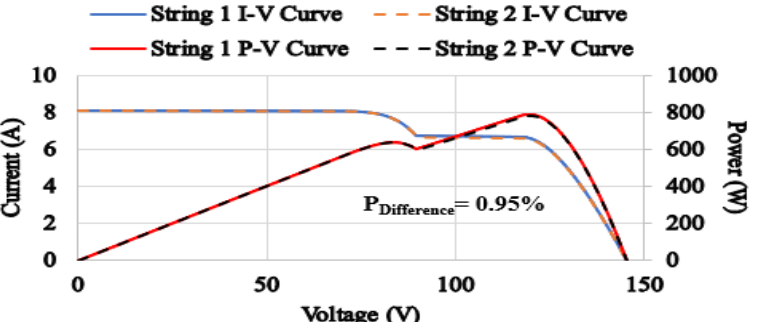
Figure 4. Inspection of the PV modules at day 1 of operation, the measured P-V and I-V curves for both PV strings at 822 W/m 2 solar irradiance and a PV surface temperature of 19.7 °C.